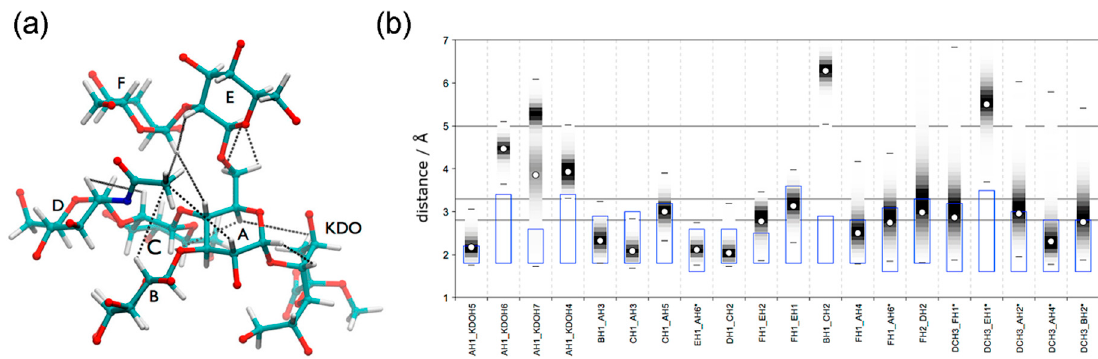
Figure 8. M. catarrhalis lgt2 Δ structure validation based on NOE data analysis. ( a ) Characteristic proton-proton contacts; ( b ) NOE-filtered (blue boxes) sampling of proton-proton distances from MD simulation (grey shades). Reproduced from [314], © 2020 The authors. Licensee MDPI, Basel, Switzerland.